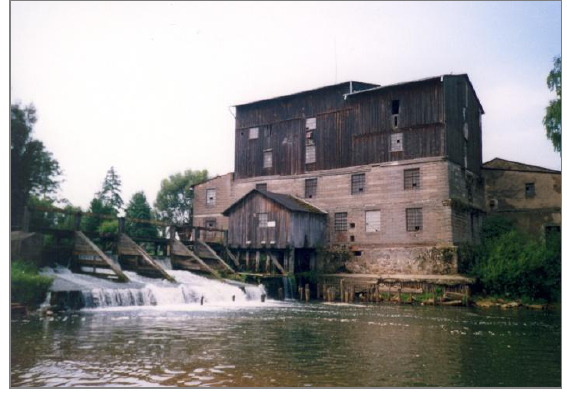
Fig. 3. Marcelin mill in Krzepice (before weir renovation) ( M. Fajer )